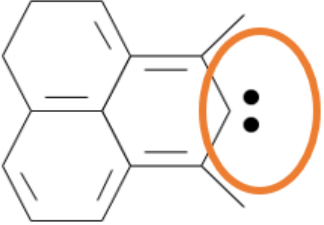
Figure 1. A lone pair of electrons situated on the edge of an aromatic sheet of carbon. This is a carbene. Wilcox et al. [35–38] attempted to further understand the role of the carbon surface, including the reactions at the carbene sites; however, the focus here was to evaluate the oxidation and adsorption mechanisms of oxidized mercury as HgCl/HgCl 2 [37] and HgBr/HgBr 2 [35] on the surface of the carbon. Computational results suggested that oxi- dized mercury compounds were the most stable to bind to the carbon surface, preferen- tially on the zigzag edge sites (the location of carbene sites) versus the armchair sites or basal plane. Hg-carbon bond lengths were calculated to range from 2.26 to 2.34 A ̊ and approximately 0.1 A ̊ shorter when oxygen is a nearest-neighbor atom resulting in in- creased stability of the Hg-C bond, further supporting Olson’s initial claim. Wilcox’s work also looked to identify how mercury donated its electrons in the oxidation and adsorption process, suggesting Hg 0 gains electrons in the 6p after adsorption and donates electrons from the 5s. The electron transfer in these calculations resulted in an oxidized surface- bound Hg complex. This complex can also be described as organomercury carbenium, as proposed by Olson et al. [32]. It is important to note that computational studies and find- ings by Wilcox et al. were conducted using graphene sheet simulations under the assump- tion that all activated carbon surfaces would behave in a graphene-like manner. This is also how Radovic et al. originally modeled the carbene [29]. Rodriguez et al. [26] studied graphitic-like activated carbons versus lignocellulosic- based activated carbons, whose carbon rings are less aromatic for the adsorption of mer- cury. Activated carbon produced from bituminous coal (more aromatic) performed far better for mercury adsorption compared to the more aliphatic-derived activated carbons from coconut shells and wood. This study also hydrogen-treated carbons at 850 °C to sta- bilize their carbene sites by hydrogasification of functional groups and loosely bound car- bon atoms resulting in condensation of the graphene layers [39]. The resulting mercury breakthrough curve for the highly aromatic bituminous coal-based AC became very sim- ilar to that of the wood- and coconut-based carbons upon stabilization. We hypothesized this phenomenon was a result of the stabilization of carbene sites which are more available in aromatic carbons. We concluded that the carbene availability of the carbon matrix was higher in the coal-based carbon; therefore, the surface was more reactive for elemental mercury removal. When activated carbon is used in an experimental or industrial setting, it cannot be assumed that all raw materials such as coconut- or wood-based activated car- bons possess these graphitic and aromatic sheets. 1.3. Oxygen Functional Groups The early work of Li et al. (2002 & 2003) [18,40] was one of the first to set out to un- derstand the mechanisms of elemental mercury adsorption at 125 °C via activated carbon surface enhancements with oxygen. In their work, two bituminous-coal-based ACs were compared to each other when oxidized with heated air (420 °C) and room temperature